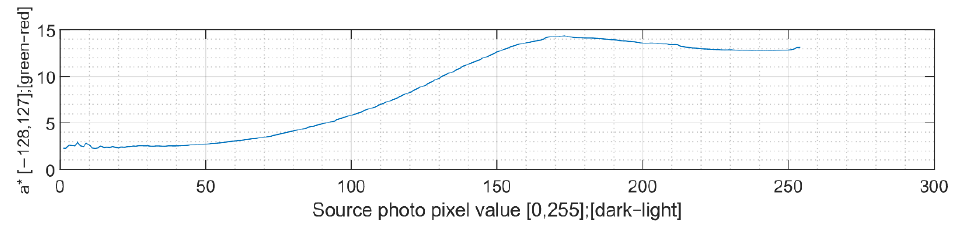
Figure 9. CIELAB a* characteristic of wood-engraved picture.